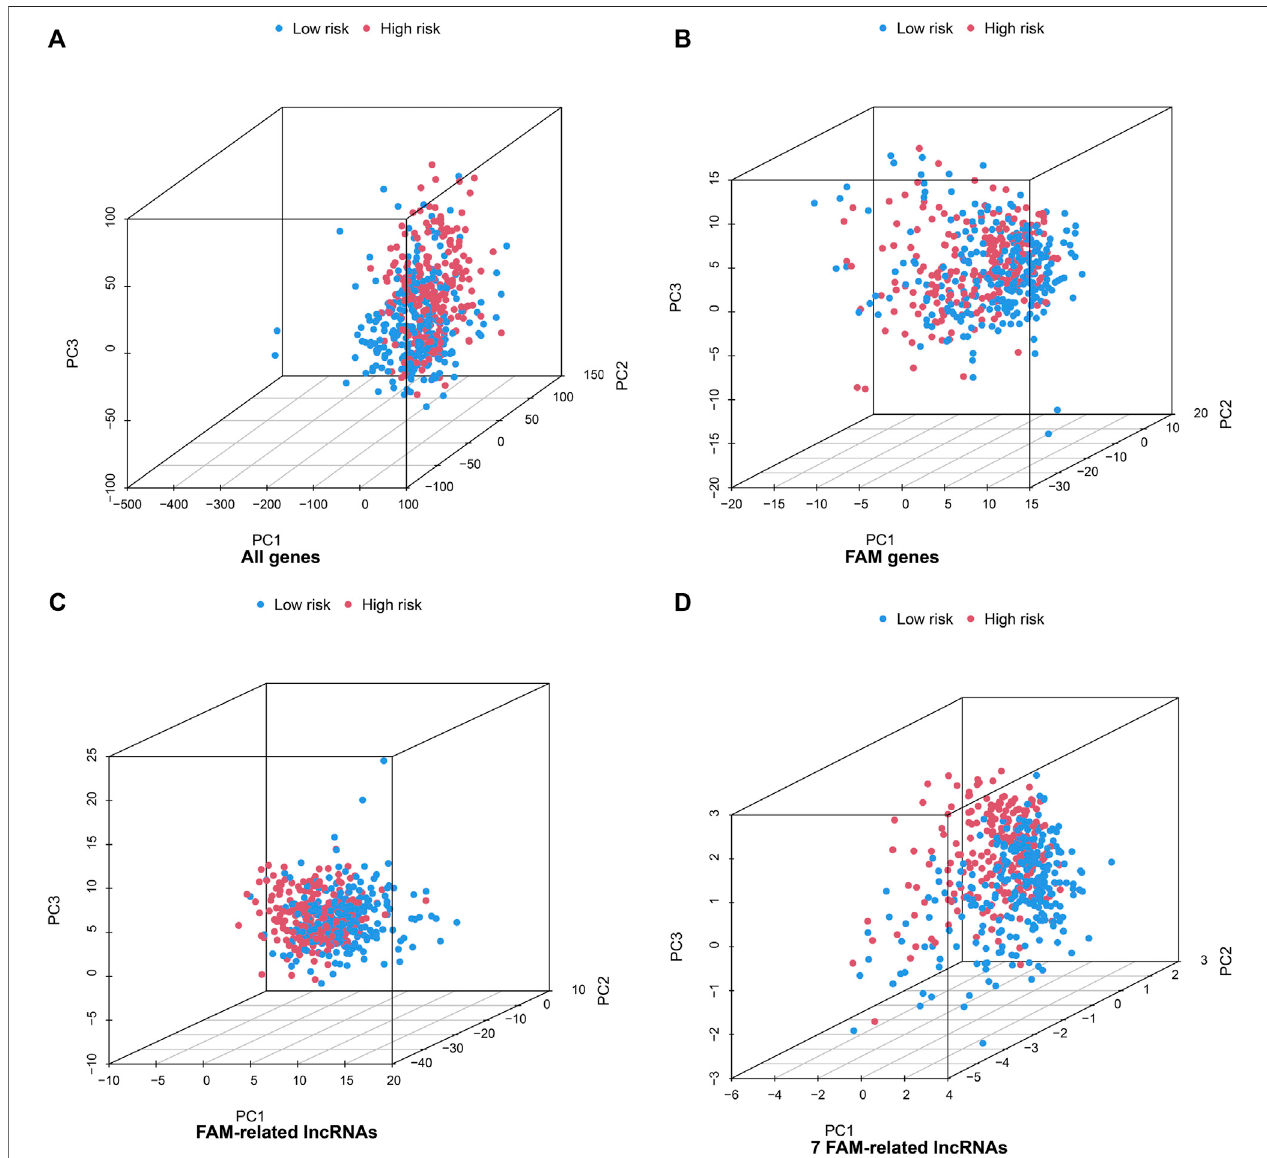
FIGURE 4 | Principal component analysis between the high- and low-risk groups based on (A) all gene expression pro fi les, (B) FAM genes (C) FAM-related lncRNAs, and (D) risk model based on the 7 FAM-related lncRNAs in the entire TCGA set.